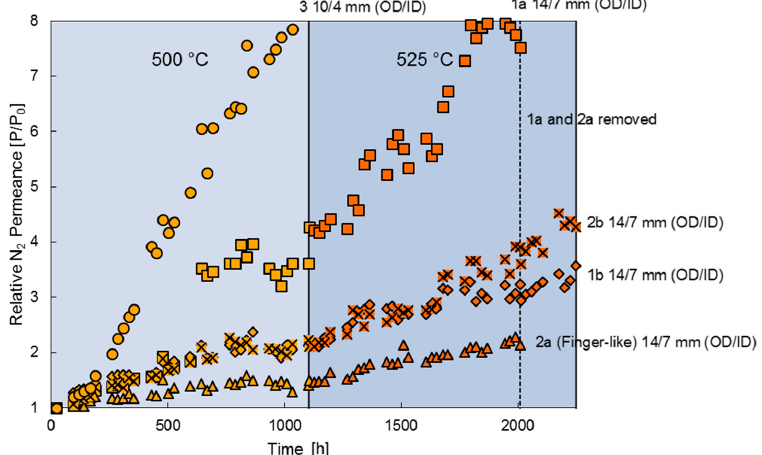
Figure 7. Relative nitrogen permeance of the membranes 1a to 3 in the long-term membrane test.